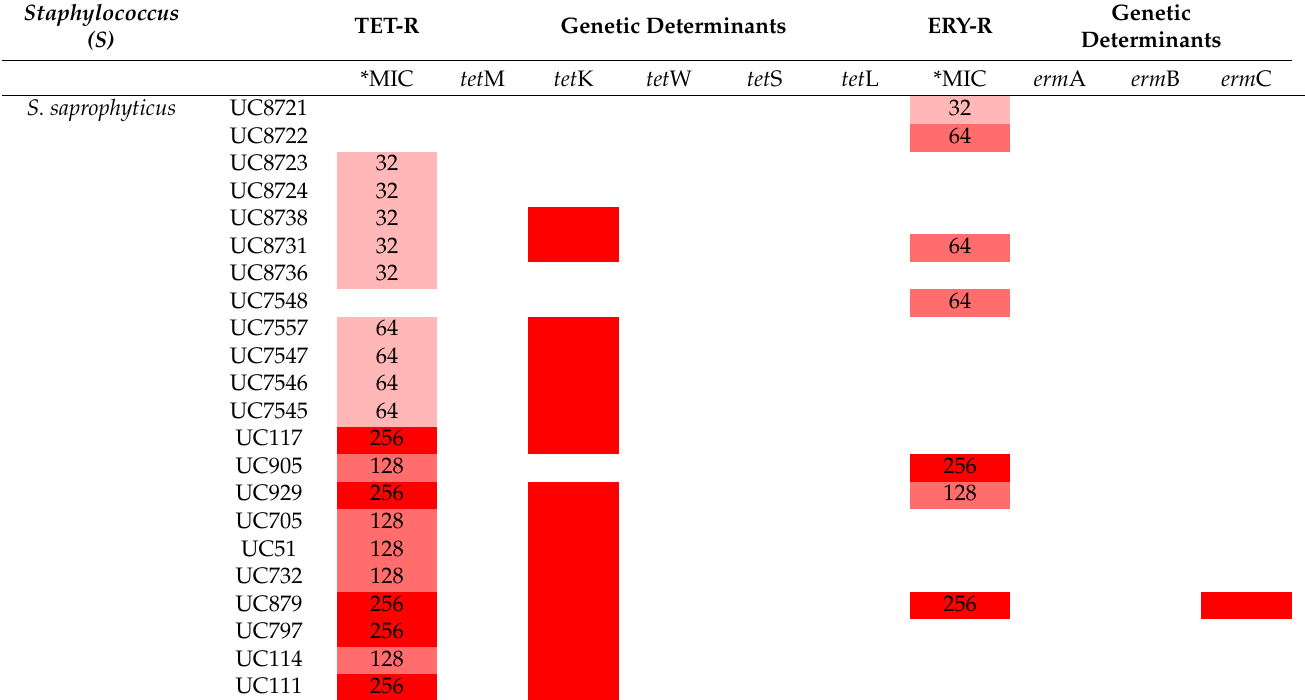
Table 4. Tetracycline- (TET-R) and erythromycin- (ERY-R) resistant Staphylococcus strains. MIC values were measured by broth microdilution method using CAMHB ( µ g/mL) and the distribution of the genetic determinants investigated in this study. Staphylococcus